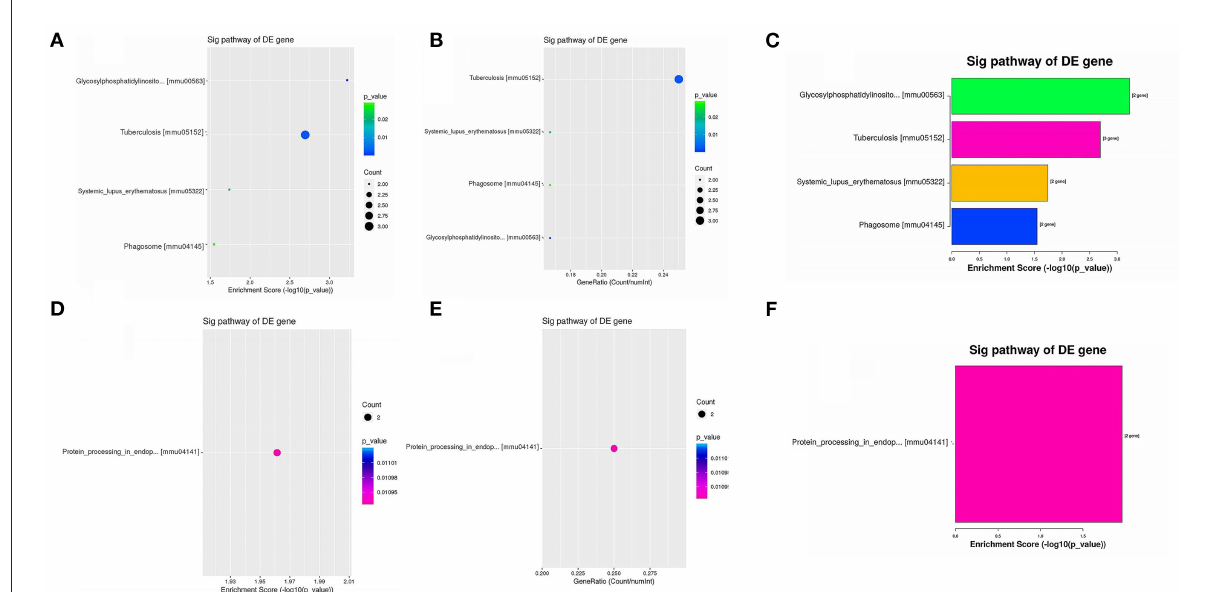
FIGURE3 Enriched KEGG pathways of upregulated DEGs and downregulated DEGs. (A,B) Dot plots showing the enrichment score (–log10[ p -value]) of significantly enriched pathways (A) and the gene ratio of the top 10 most significantly enriched pathways (B) . (C) Bar plot showing the top 10 enrichment scores (–log10[ p -value]) of significantly enriched pathways. (D,E) Dot plots showing the enrichment score (–log10[ p -value]) of the significantly enriched pathways (D) and the gene ratios of the top 10 most significantly enriched pathways (E) . (F) Bar plot showing the top 10 enrichment scores (–log10[ p -value]) of significantly enriched